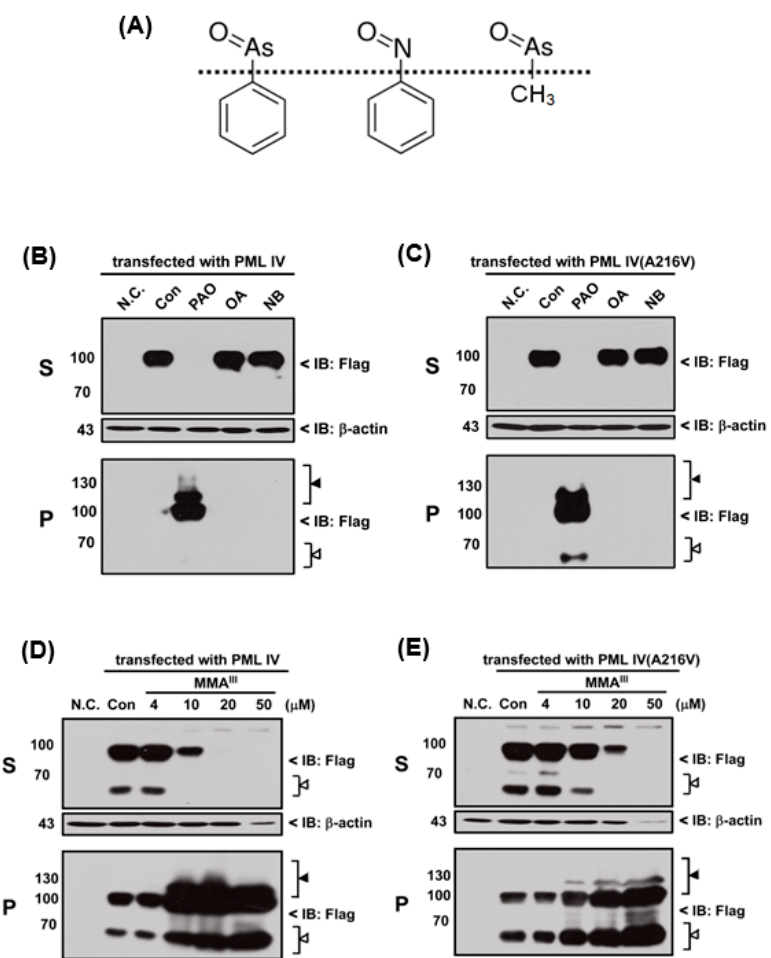
Figure 5. Comparison of different chemical compounds on induction of PML-IV or mutant PML-IV (A216V) proteins solubility changes. ( A ) The molecular structures of PAO, Nitrosobenzene (NB) and monomethylarsonous acid (MMA III ). Flag-PML-IV or PML-IV (A216V) over-expressed HEK293T cells were treated with 4 µ M phenylarsine oxide (PAO), 100 nM Okadaic acid (OA) and 4 µ M Nitrosobenzene (NB) for 6 h; and then the PML-IV ( B ); and PML-IV (A216V) ( C ) protein solubility changes were determined by Western blot. Similarly, PML-IV ( D ); and PML-IV (A216V) ( E ) protein solubility changes were also determined in case of MMA III treatment in a concentration-dependent manner (i.e., 4, 10, 20 and 50 µM). The white triangle ( △ ) indicates the protein degradation and black triangle ( ▲ ) indicates protein modification. PML protein and β -actin were detected using anti-Flag and anti- β -actin primary antibodies, respectively.